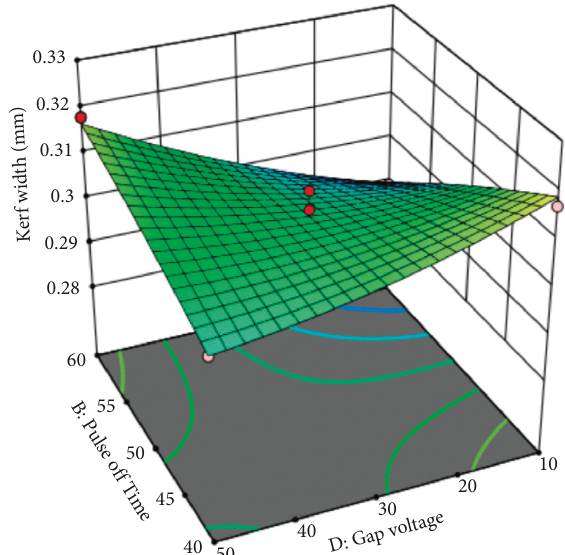
Figure 15: Joint performance on kerf width by IP and off and SV.